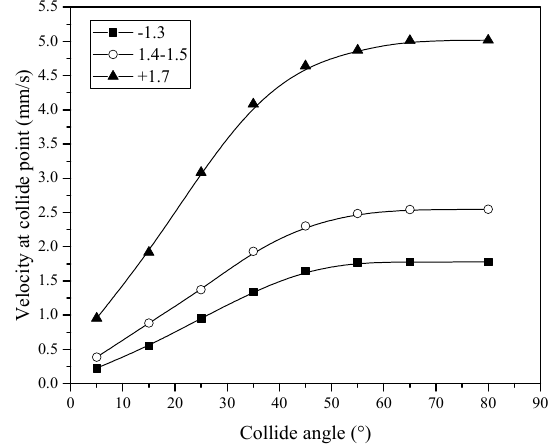
Figure 12. Particle velocity at collision point.